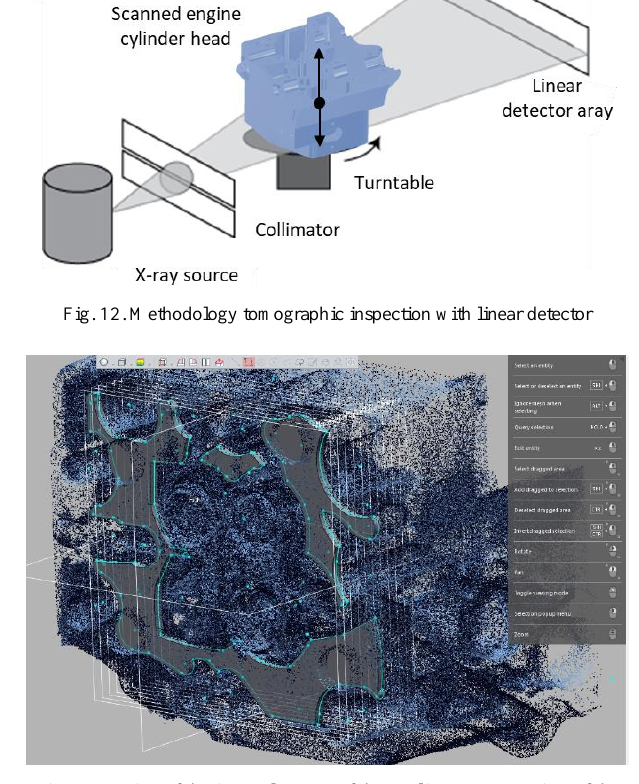
Fig. 13. Design of the internal spaces of the cooling system – view of the measurement point cloud obtained from the tomographic scanning process The performed measurements (described in sections